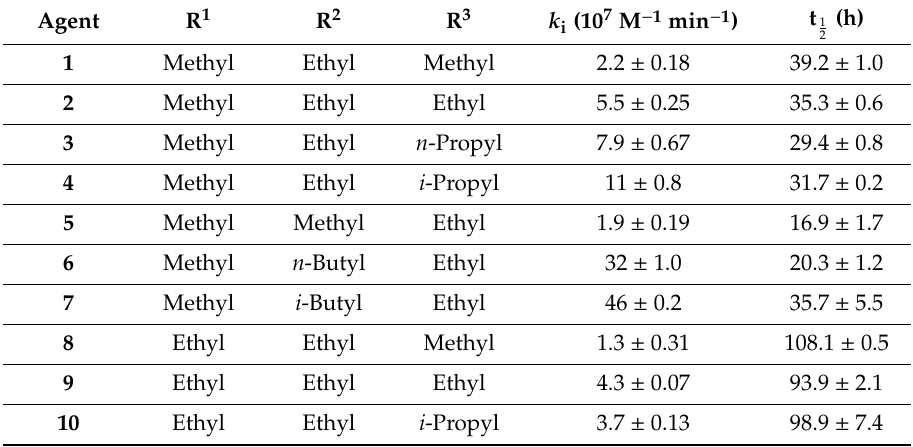
Table 1. Chemical structure of tested organophosphonothioates, AChE inhibition kinetics (k i ) and stability in human plasma ( t ½ ).